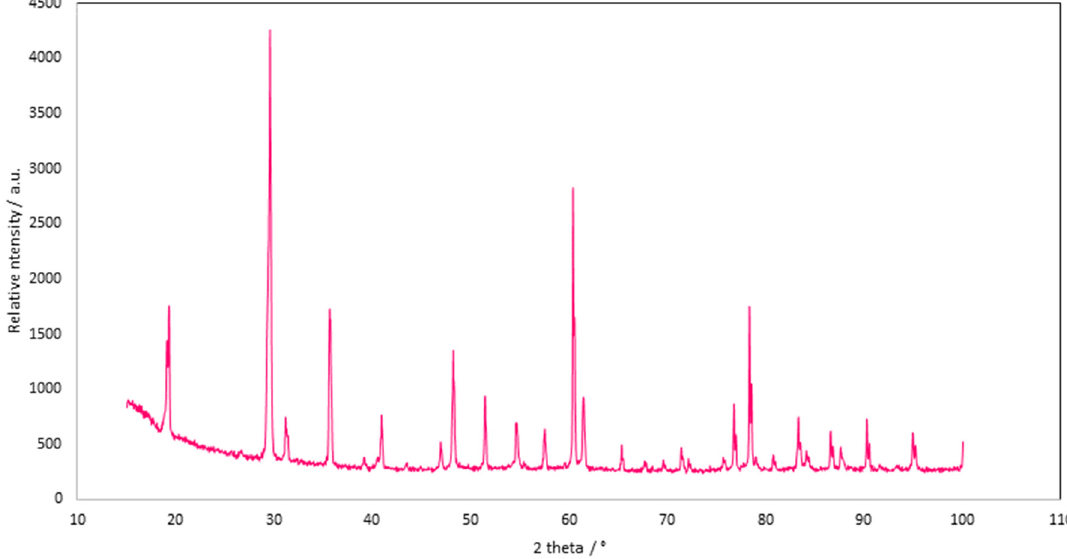
Figure 5. XRD pattern of rubidium perrhenate crystals.